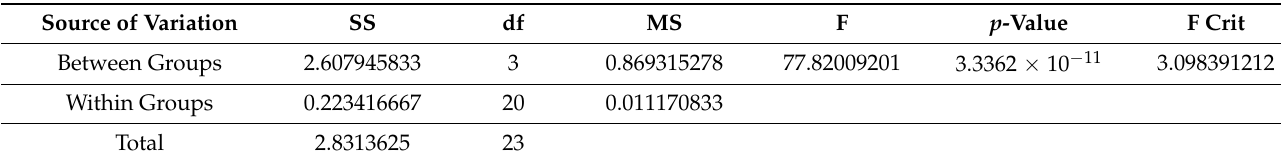
Figure 7. Visual summary of pull-off adhesion tests with a coated plywood specimen, from left: casein; casein–ATH–mica, casein–ATH and casein–mica. Table 3. One-way ANOVA analysis of pull-off test